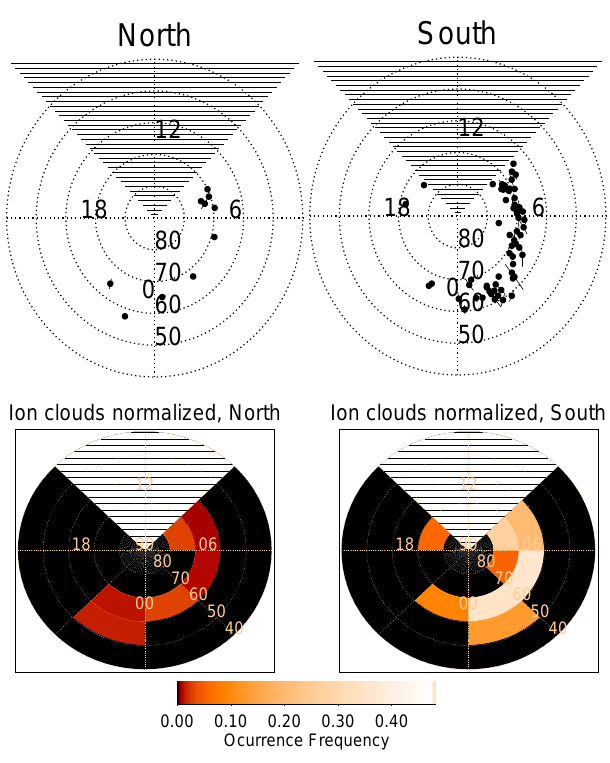
Fig. 4. Spatial distribution of ion clouds in geomagnetic coordi- nates in the northern (left) and southern (right) hemisphere. The upper panels show the position of individual ion clouds and the lower panels show the relative occurrence of ion clouds (number of ion clouds divided by number of satellite passes). There are, in total, 15 ion clouds observed in the northern hemisphere and 107 in the southern hemisphere. Note that ion clouds between 9 and 15 MLT are not included.